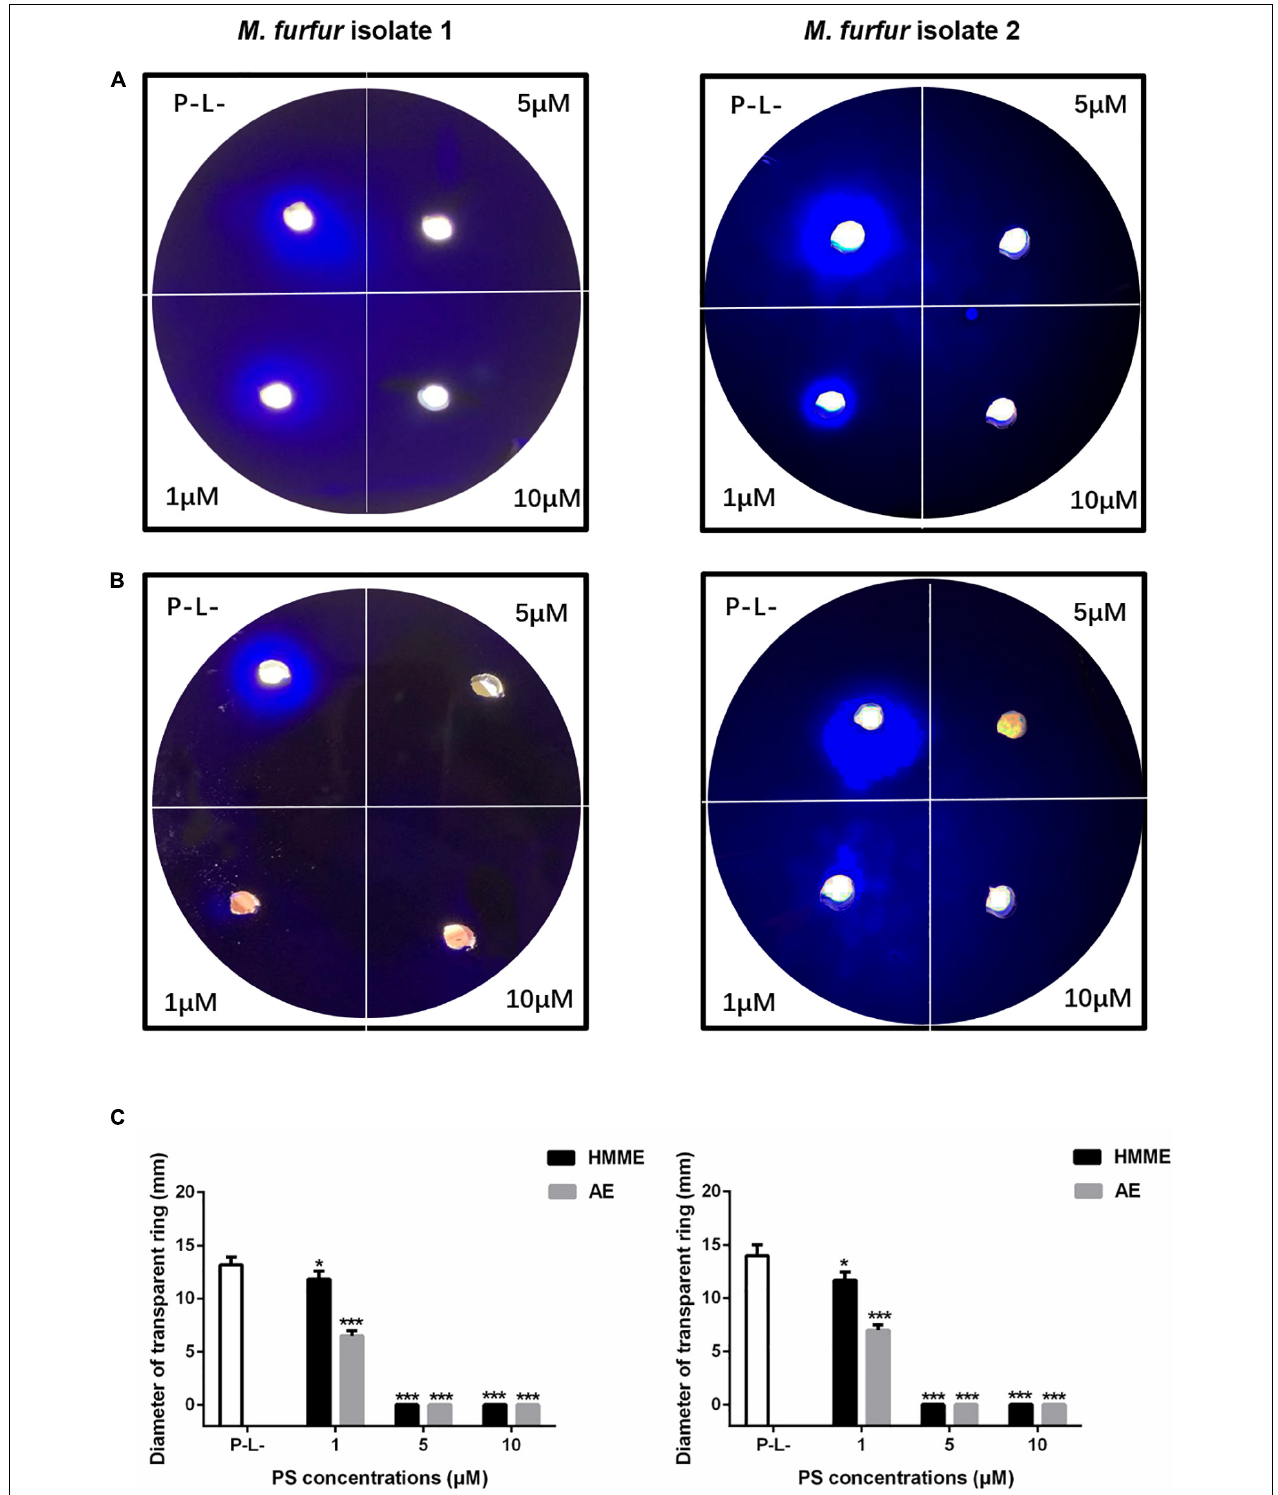
FIGURE 8 | Secreted protease activity of M. furfur after HMME and AE-mediated aPDT. (A) M. furfur cells treated with different concentrations of HMME and irradiated with 96 J cm − 2 of light and incubated in whole milk plate for 7 days (P-L-: without any treatment); (B) M. furfur cells treated with different concentrations of AE and irradiated with 96 J cm − 2 of light and incubated in whole milk plate for 7 days (P-L-: without any treatment); and (C) diameters of transparent ring of M. furfur cultured in whole milk plate (P-L-: without any treatment). Each value refers to mean ± standard deviation (SD; n = 3; ns: no significance, * P < 0.05, *** P < 0.001).